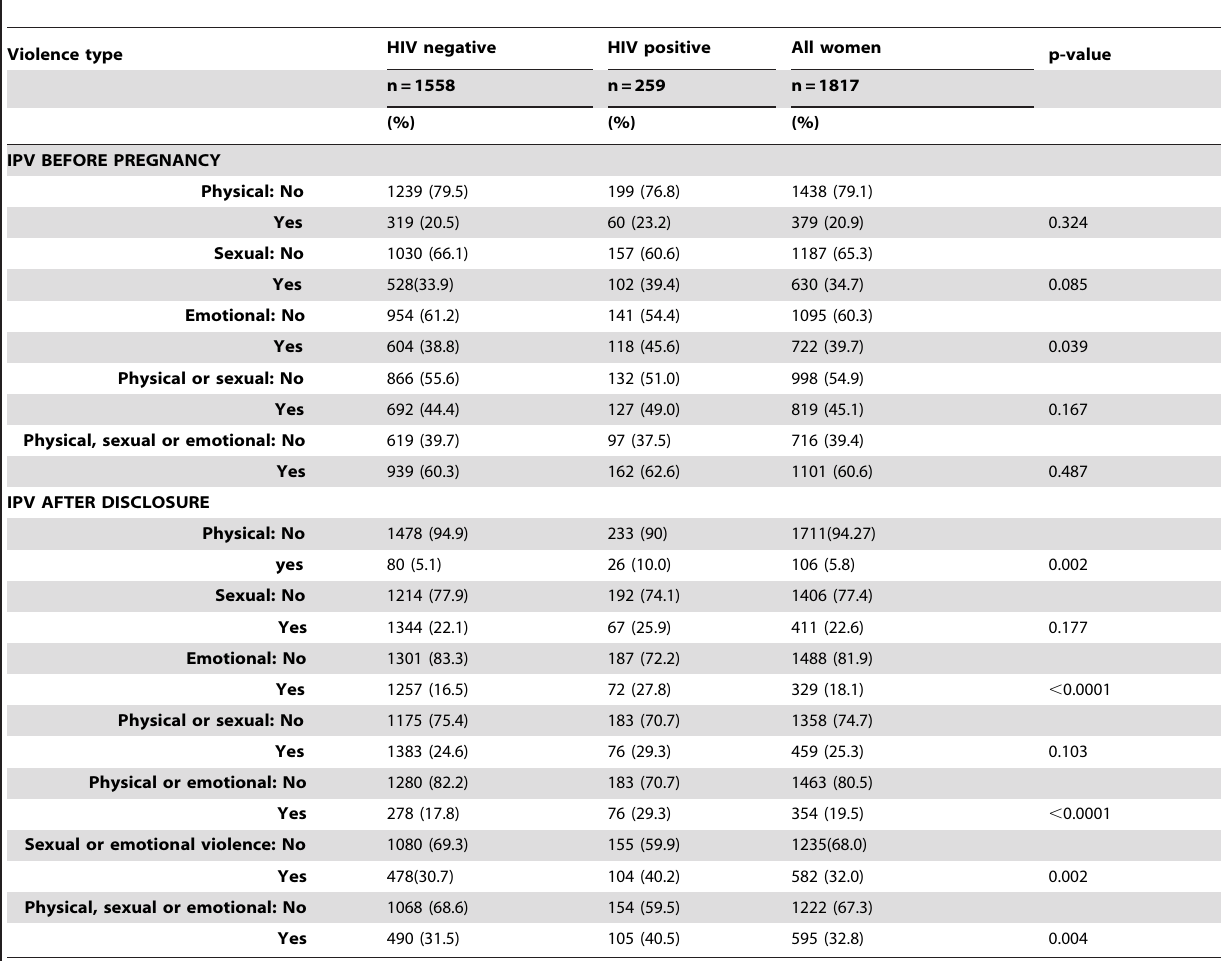
Table 1. Prevalence of intimate partner violence 12 months before pregnancy and after HIV disclosure by HIVsero-status.